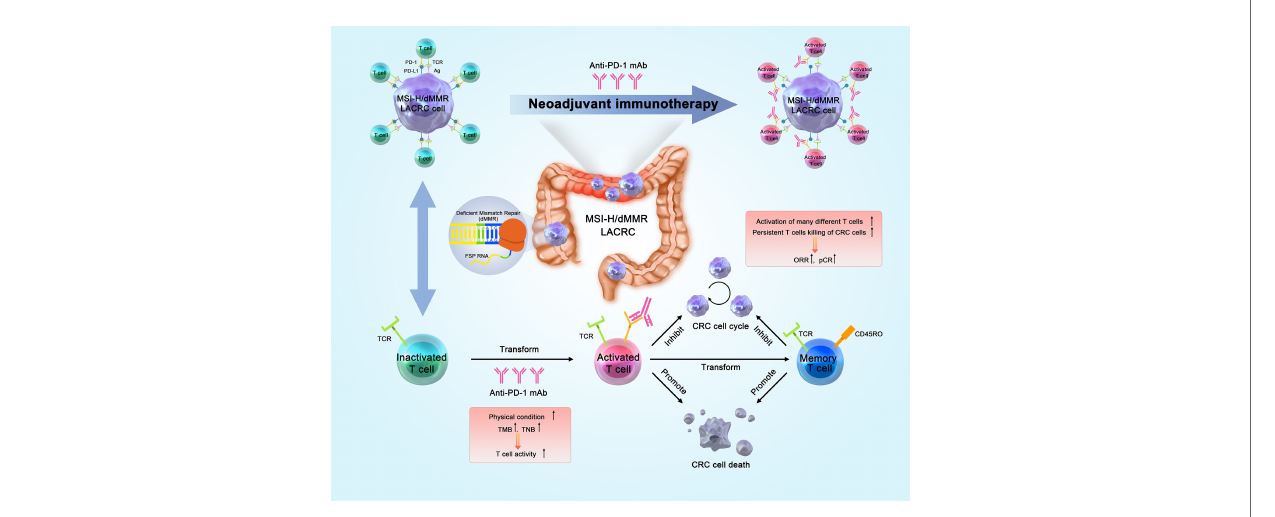
FIGURE 1 | Anti-tumor mechanism of nIT in patients with MSI-H/dMMR CRC. nIT, Neoadjuvant immunotherapy; MSI-H, Microsatellite instability-high; dMMR, De fi cient mismatch repair; CRC, Colorectal cancer; TMB, Tumor mutation burden; TNB, Tumor neo-antigen; ORR, Objective response rate; pCR, Pathological complete